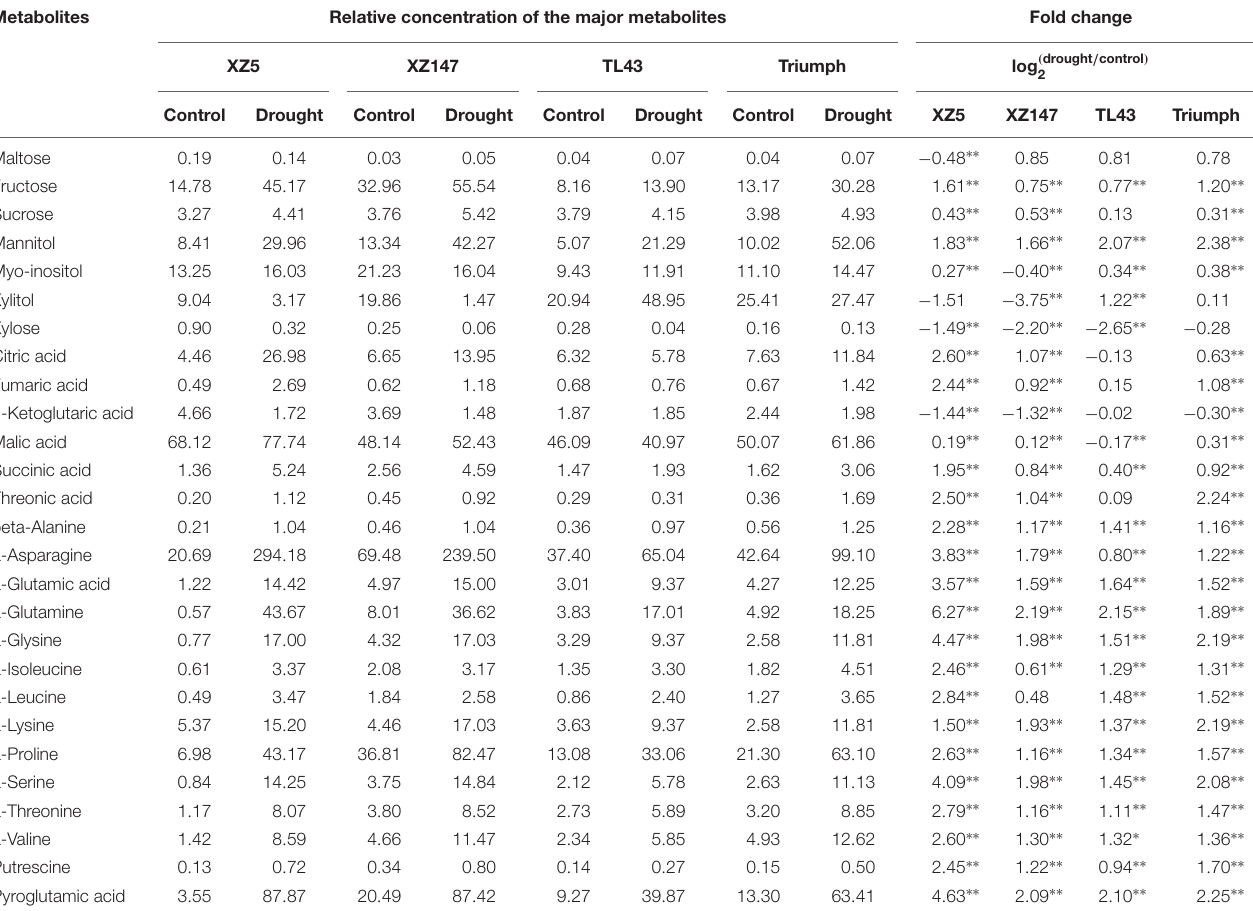
TABLE 1 | Relative concentration and the fold changes of the major metabolites in the grains of the different barley genotypes under water stress. Metabolites Relative concentration of the major metabolites